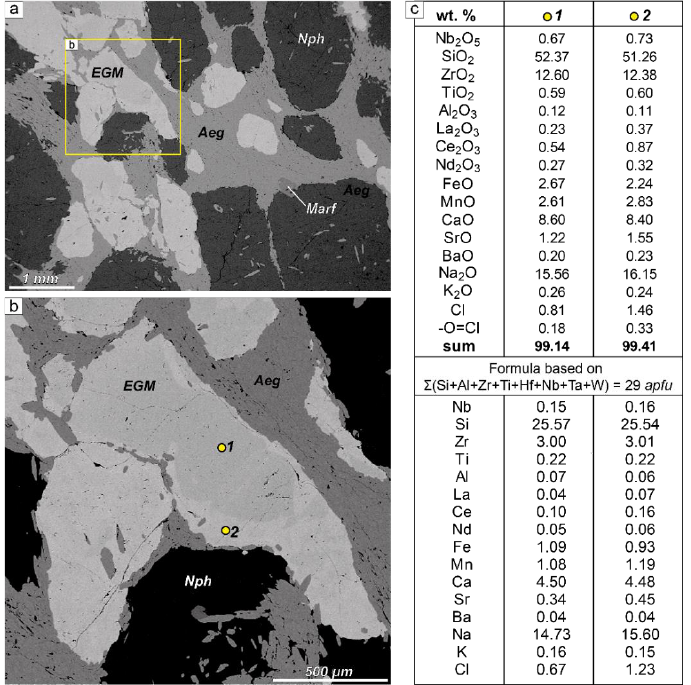
Figure 3. Fresh EGMs. ( a ) EGM grains in eudialyte lujavrite (sample LV-222/177, sampling point 1 in Figure 1), BSE image; ( b ) detailed BSE image of a fragment of Figure 3a; EGM grains contain almost no cracks and has smooth boundaries; yellow dots are microprobe analysis points; ( с ) chemical composition of EGM grain shown in Figure 3b (point 1 = grain core; point 2 = grain rim). apfu — atoms per formula unit.